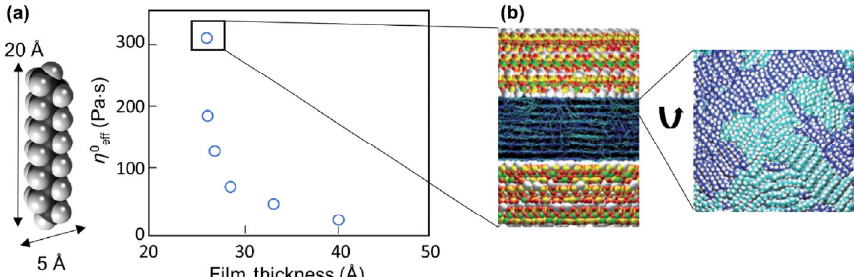
Fig. 2 Experimental data showing viscosity enhancement with decreasing film thickness for n -dodecane (a) adapted from Ref. [142]. From the results of all-atom MD simulations, the high viscosity state has recently been attributed to a transition to a crystalline phase (b) image reprinted with permission from Ref. [147] © Royal Society of Chemistry. Dodecane molecule and approximate dimensions shown for comparison with transition ( ≈ 5 molecular